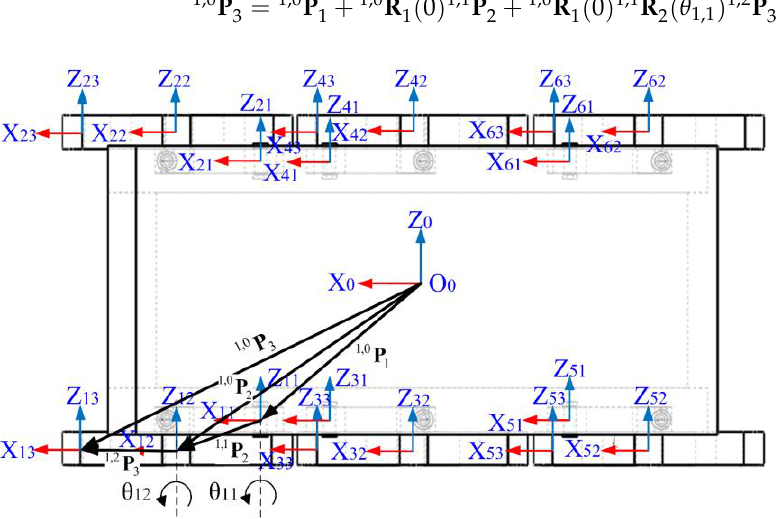
Figure 3. Single-leg differential kinematics of six-track robot.